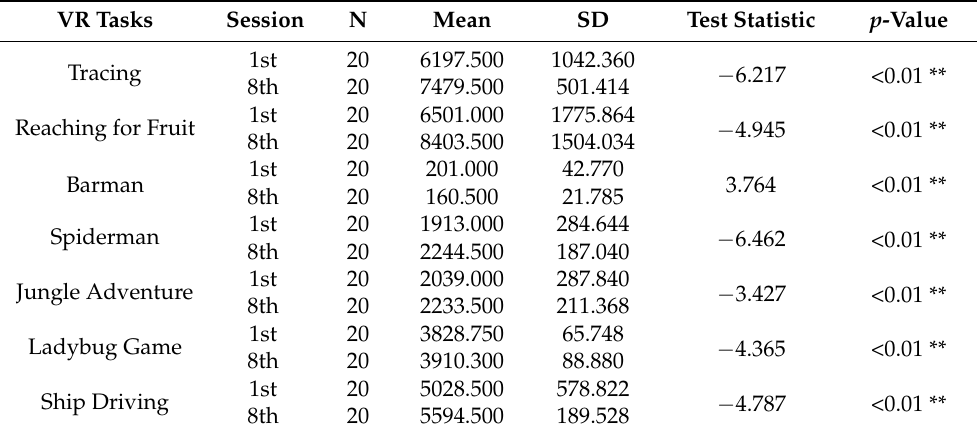
Table 4. Summary statistics and paired t -test for comparing movement task performance outcomes between pretest and